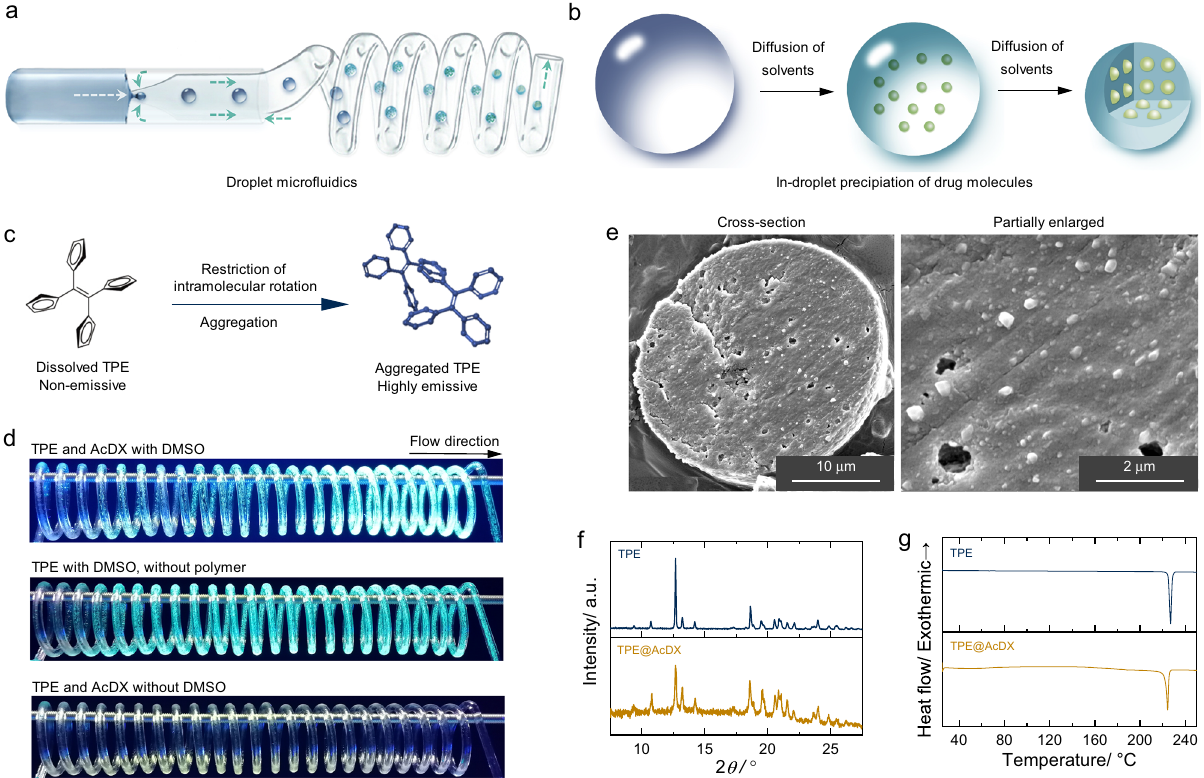
Fig. 1 Preparation of nano-in-micro structured microspheres. a The preparation of high drug-loaded microspheres by droplet micro fl uidics. b The structural evolution of the droplets during solidi fi cation. c Propeller-shaped TPE is non-emissive when dissolved but becomes highly emissive when its molecules are aggregated, due to the restriction of intramolecular rotation of its phenyl rotors against its ethylene stator in the aggregate state. d Droplets generated by fl ow-focusing micro fl uidic device pass through the spiral-shaped capillary tube under ultraviolet irradiation. e Scanning electron microscope images of whole and enlarged cross-section of TPE@AcDX microspheres. X-ray powder diffraction ( f ) and differential scanning calorimetry ( g ) of TPE@AcDX microspheres and